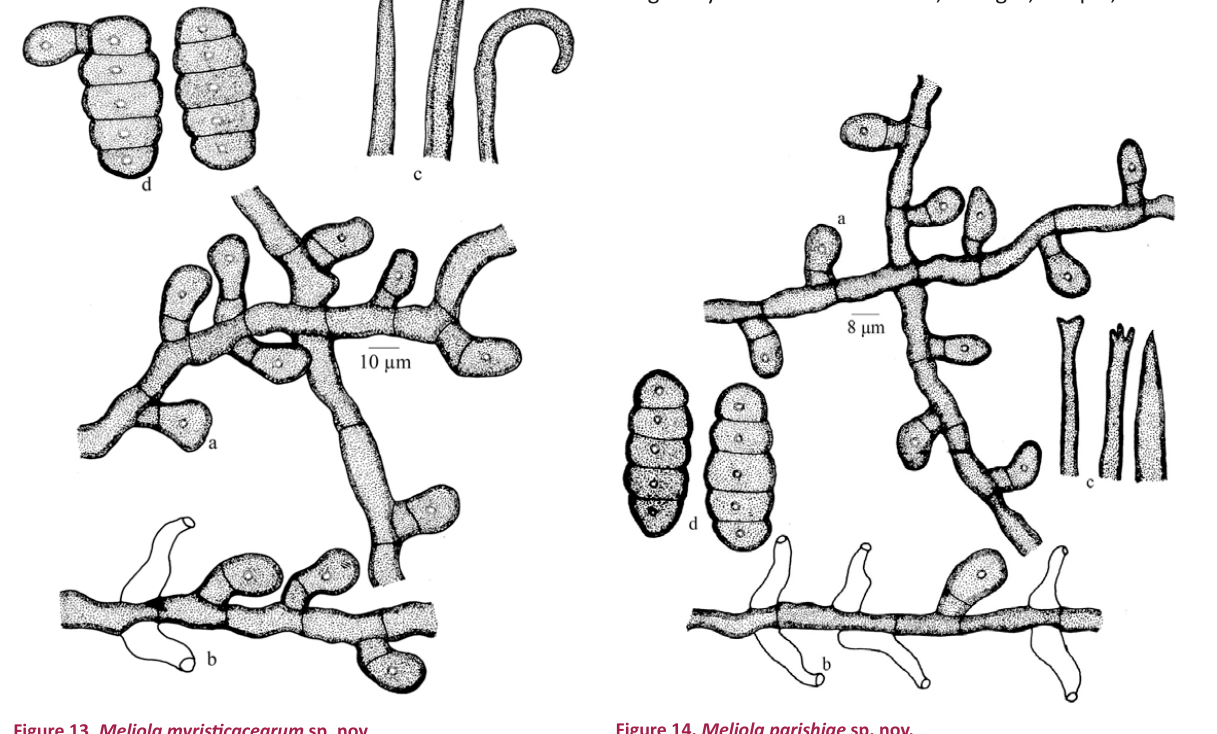
Figure 13. Meliola myristicacearum sp. nov. a - Appressorium, b - Phialide, c - Apical portion of the mycelial setae;